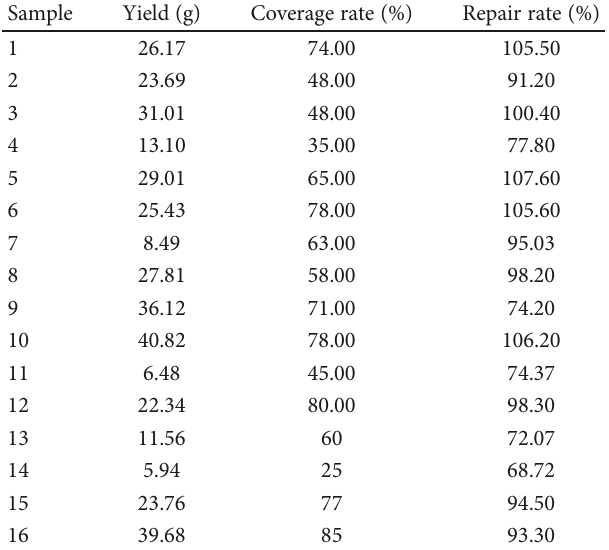
Table 5: Orthogonal experiment design